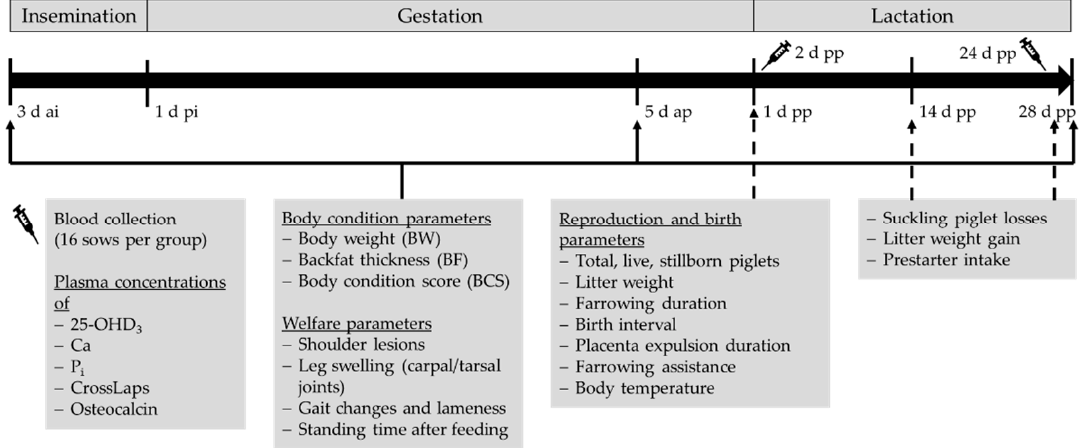
Figure 1. Schematic representation of data collection during the experimental period (3 d ai to 28 d pp; not to scale).